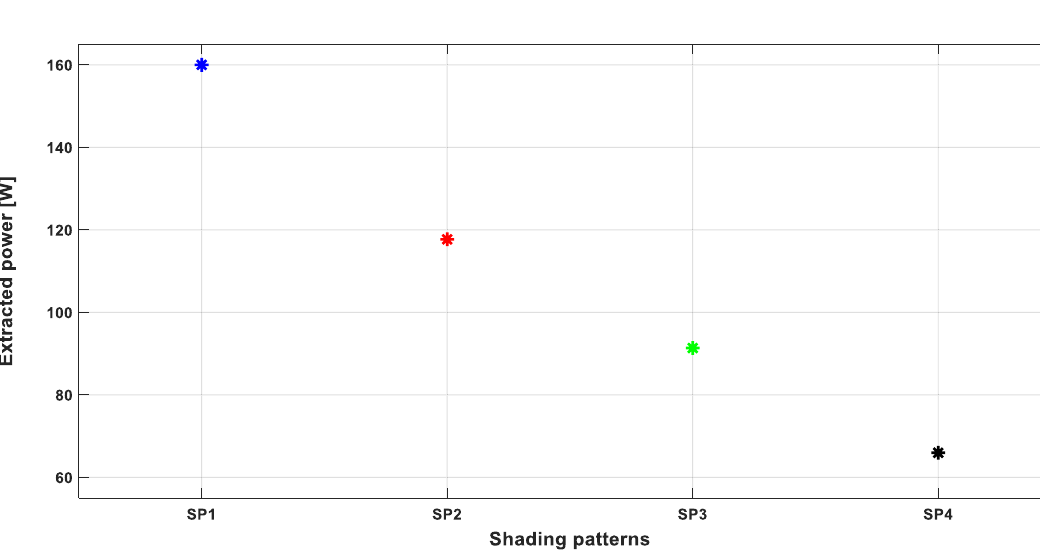
Figure 10. PV power extracted using the hybrid GWO–PSO based MPPT for the four different